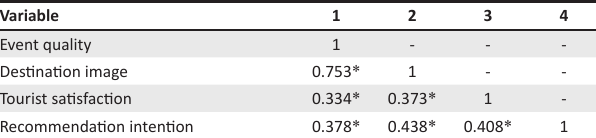
TABLE 3: Correlations between